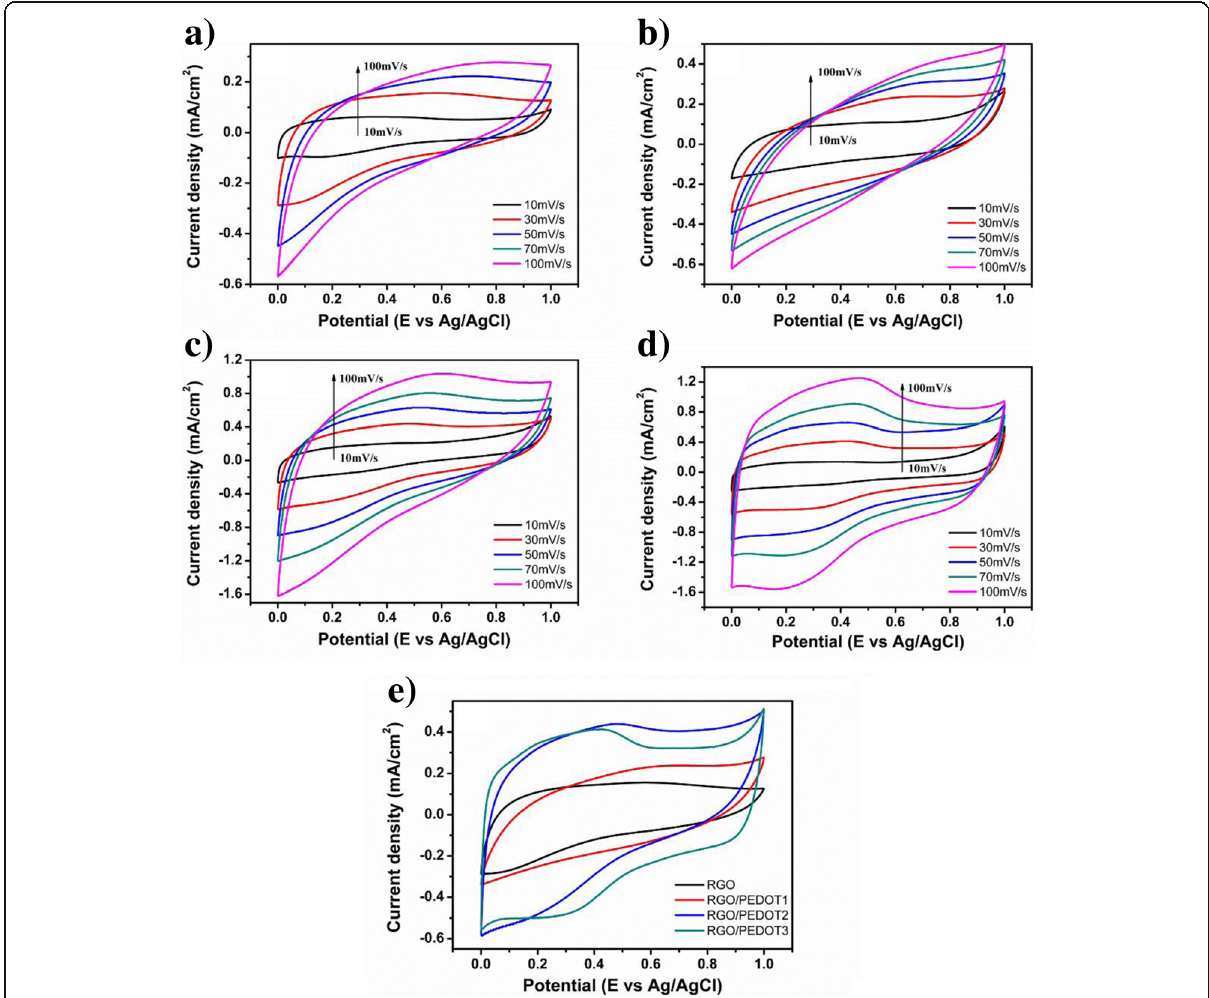
Fig. 7 CV curves of a rGO, b rGO/PEDOT1, c rGO/PEDOT2, and d rGO/PEDOT3 at different scanning voltage rate, and e compared CV curve of rGO with different rGO/PEDOT at 30 mV/s scanning voltage